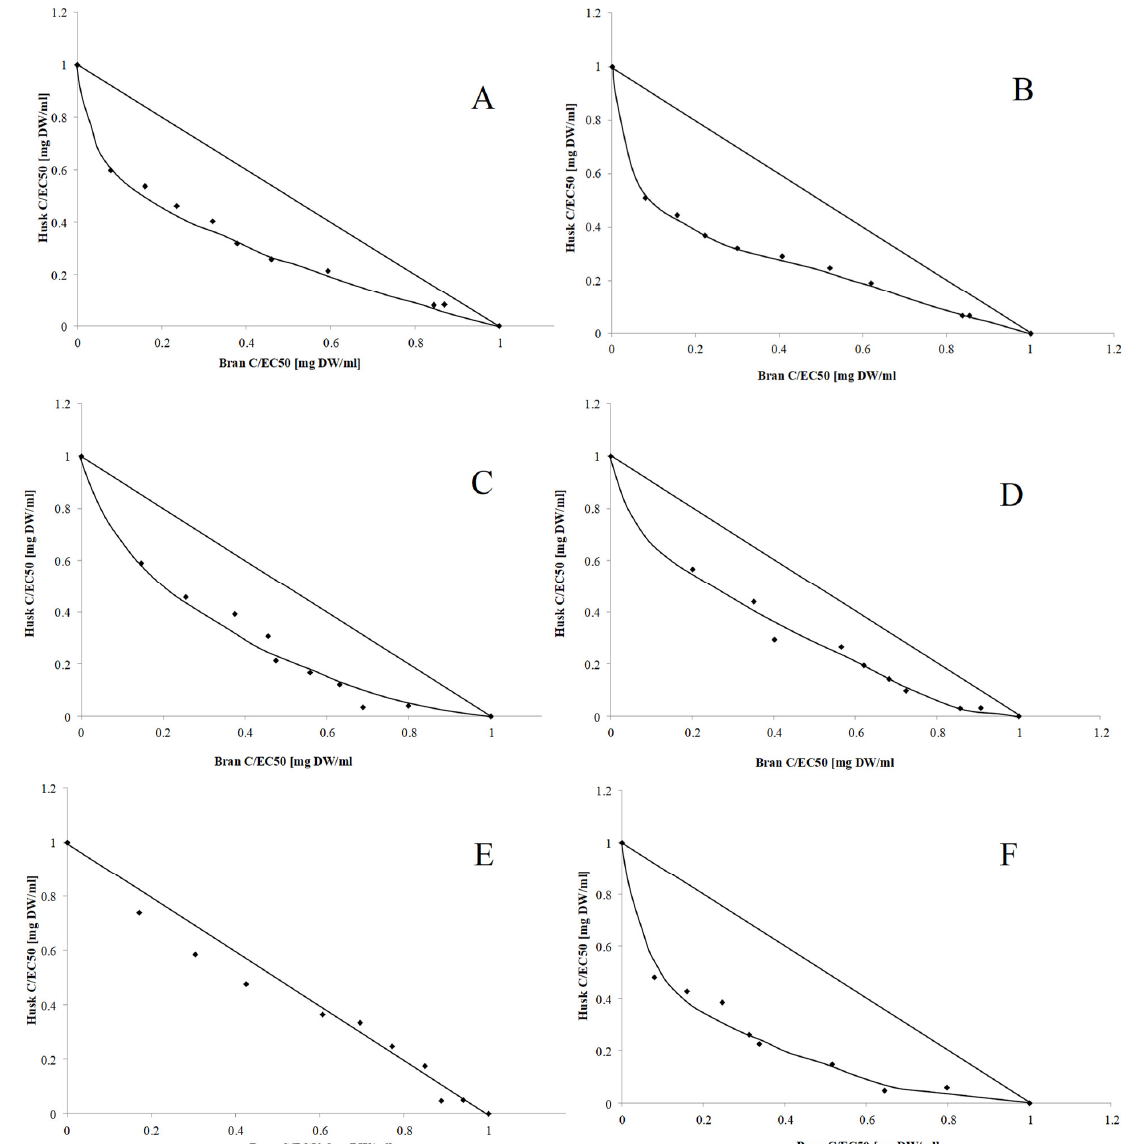
Figure 2. Dose-normalized isobolograms for the antioxidant activity of OH and OB components: antiradical activity of buffer extract ( A ) and 50% hydroalcoholic extract ( B ); CHEL of buffer extract ( C ) and 50% hydroalcoholic extract ( D ); and lipid peroxidation-inhibiting ability of buffer extract ( E ) and 50% hydroalcoholic extract ( F ).